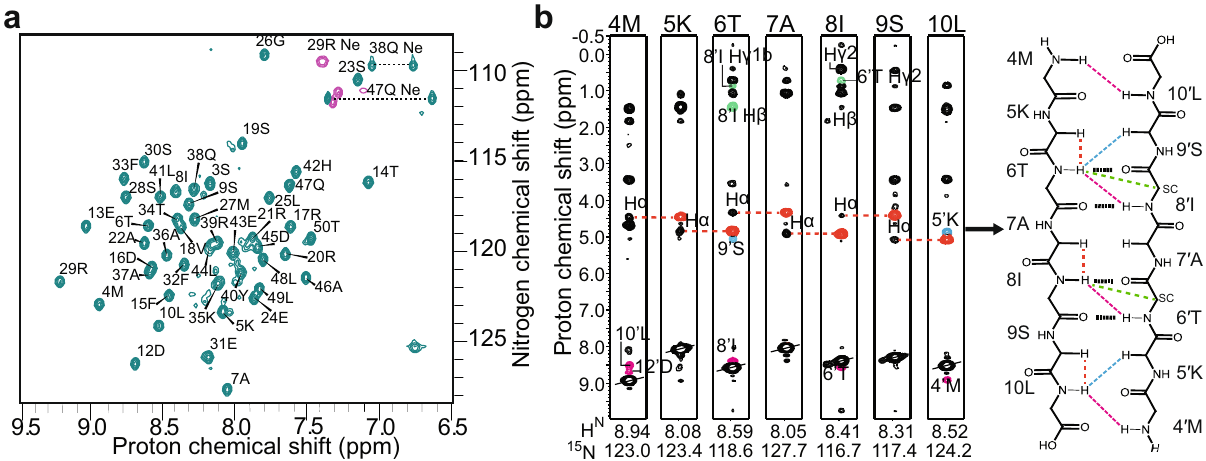
Fig. 2 Solution properties of nMazE6. a Assigned 2D 1 H- 15 N HSQC spectrum of nMazE6. Sequence speci fi c assignments are indicated on the spectrum. Horizontal dotted lines connect resonances of side chain amide protons. b Strip-plots from 15 N-edited NOESY data showing sequential intra-subunit and cross-strand long-range NOEs observed across the dimer interface. NOEs are colored black (intra-residue), red (intra-subunit i − 1 H α - i H N ), cyan (inter- subunit H α -H N ), pink (inter-subunit H N -H N ) and green (inter-subunit side chain-H N ). β -sheet topology constructed from the pattern of assigned NOEs is shown on the side. NOEs are indicated by colored broken lines. Proposed hydrogen bonding between donor-acceptor pairs in nMazE6 are indicated by black dotted